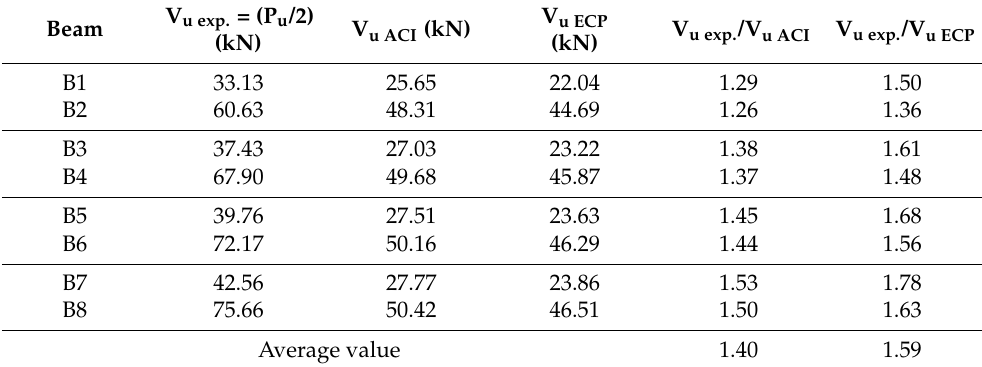
Table 8. Comparison of experimental results with the examined codes.